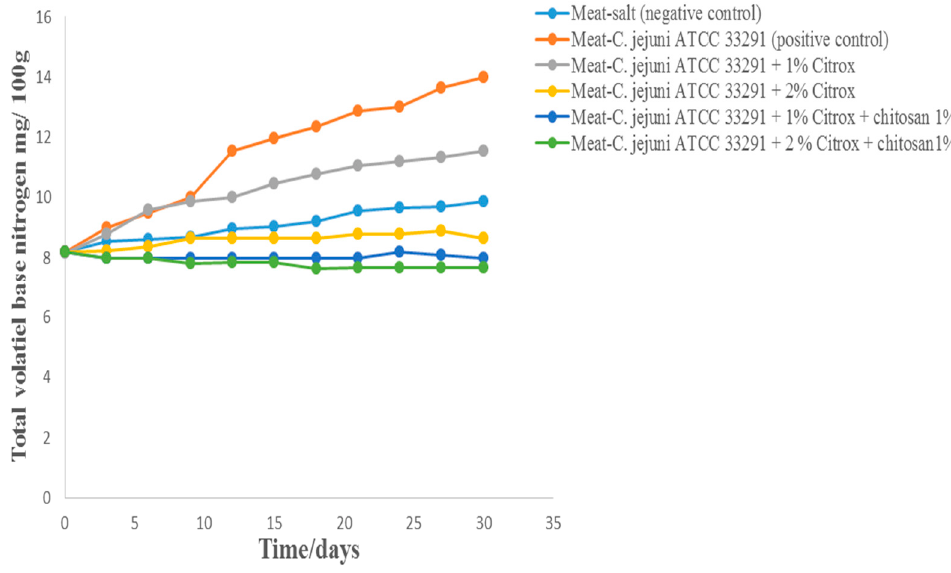
Figure 8. Total volatile base nitrogen ( TVB-N) of camel meat samples during storage at 4 °C for 30 days.